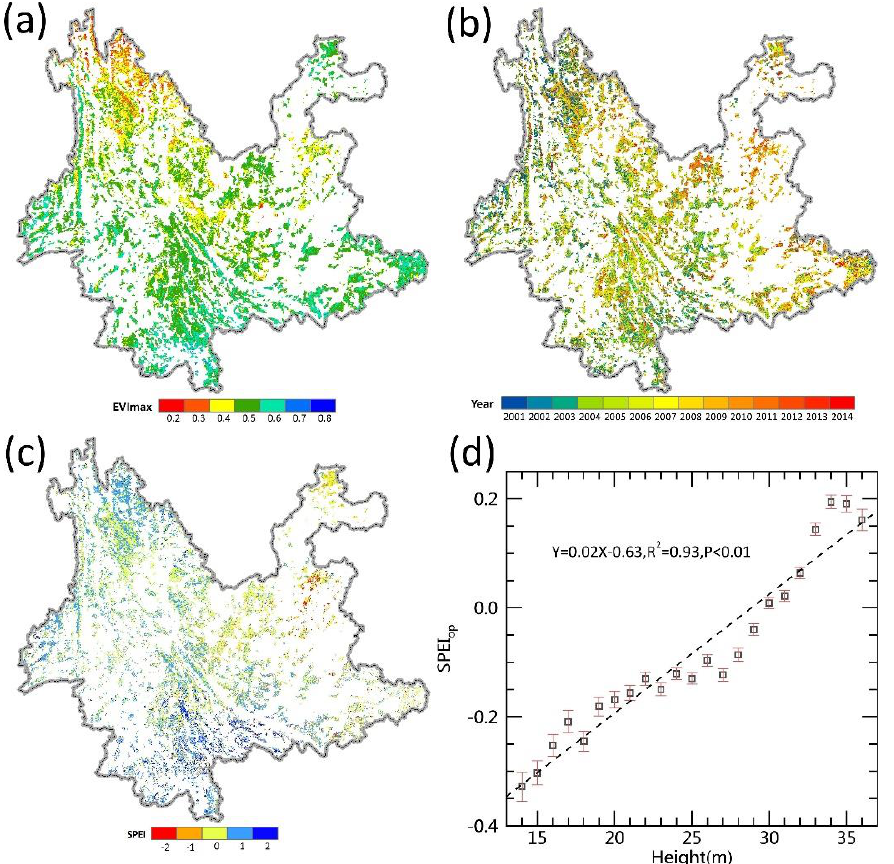
Figure 2. Water requirements of forest vary with canopy heights. ( a ) The maximum enhanced vegetation index (EVI) of forests in Yunnan during 2001–2014; ( b ) The occurrence time of the maximum EVI in ( a ); ( c ) The standardized precipitation evapotranspiration index (SPEI) value at the occurrence time of the maximum EVI ( SPEI 𝑜𝑝 ), which represents the optimal water availability for maximum growth potential; ( d ) Regression of mean SPEI 𝑜𝑝 against forest canopy height (mean SPEI 𝑜𝑝 were calculated for pixels with the same canopy heights). The white regions in ( a – c ) represent nonforest areas.